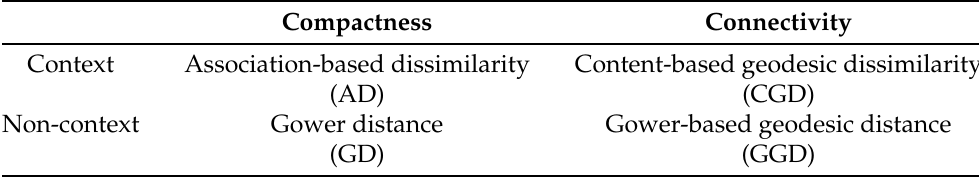
Table 1. Categorization of four dissimilarity